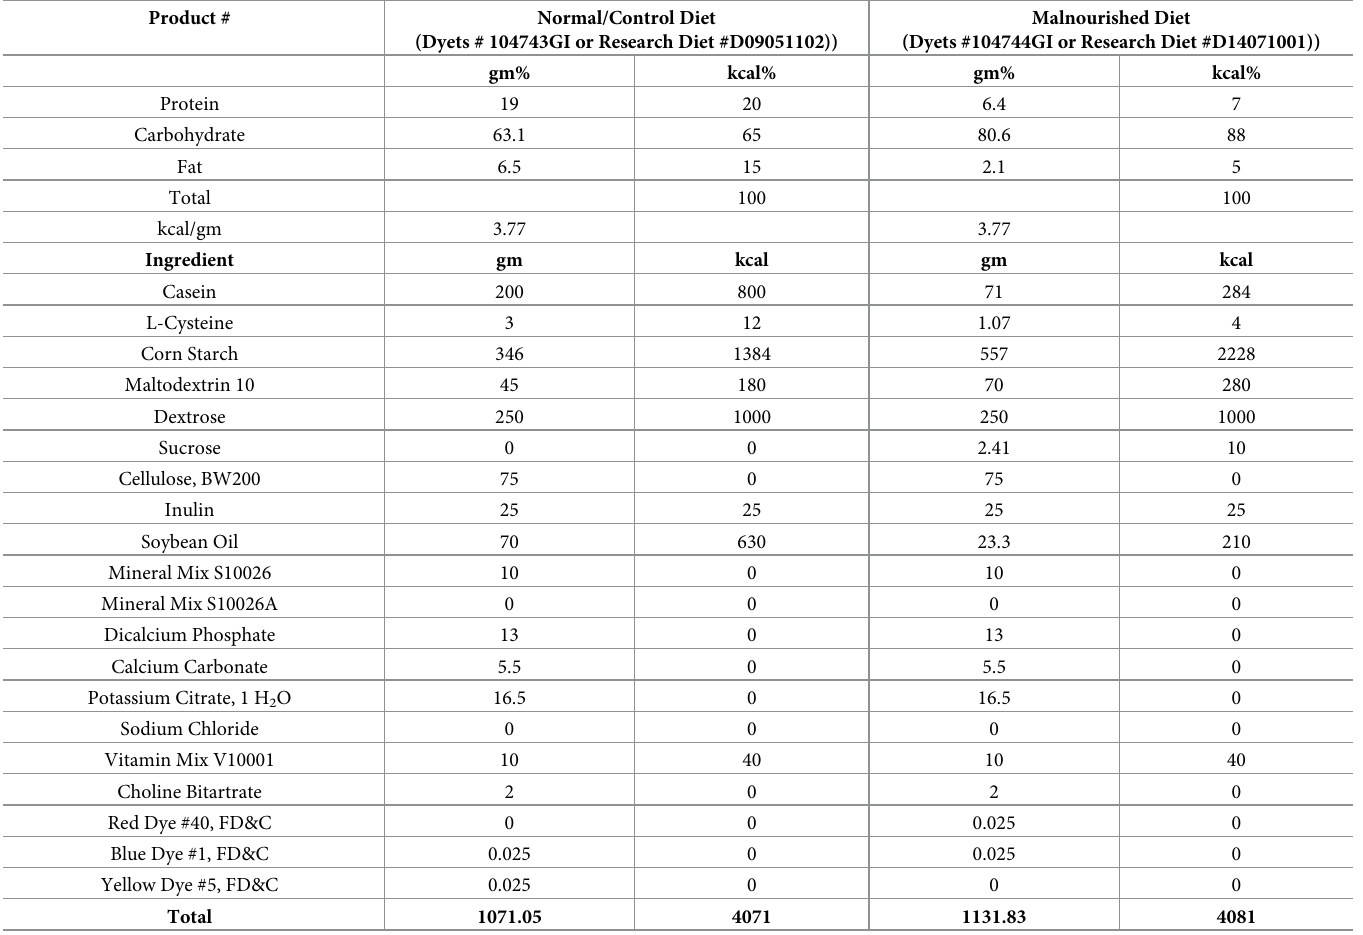
Table 1. Normal and malnourished isocaloric diets used in this study, related to Fig